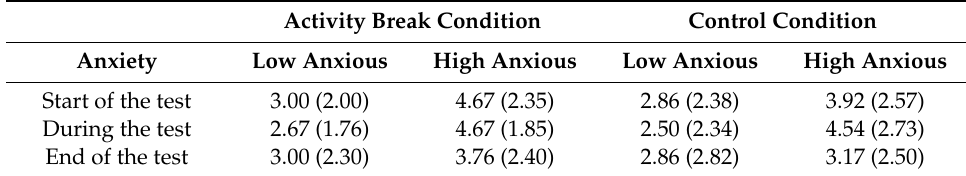
Table 1. Means (SD) of children’s perceived anxiety at the beginning, during, and at the end of the test as a function of condition and children’s anxiety